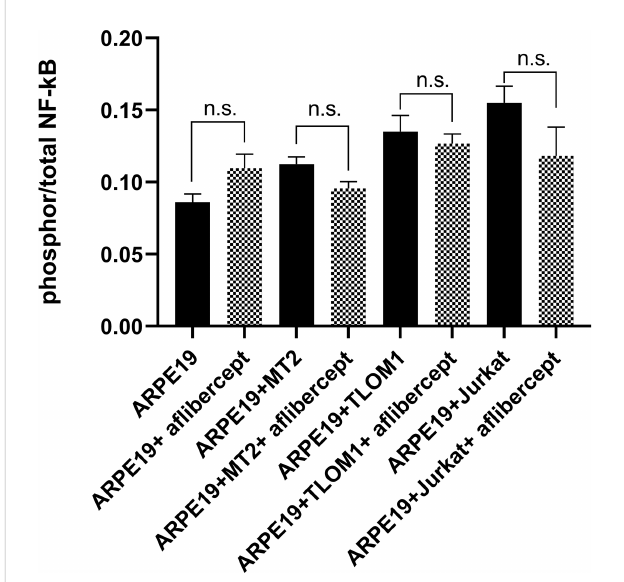
FIGURE 2 ELISA for phospho p65 NF- k B. Effect of anti-VEGF treatment on activation of nuclear factor- k B (NF- k B) in ARPE19 cells shown as the ratio of phosphor to total. No signi fi cant change in NF- k B activation of ARPE19 cells in corresponding groups was seen following a fl ibercept addition. Data are taken from three independent biological experiments and presented as the mean ± SEM (n.s., not signi fi